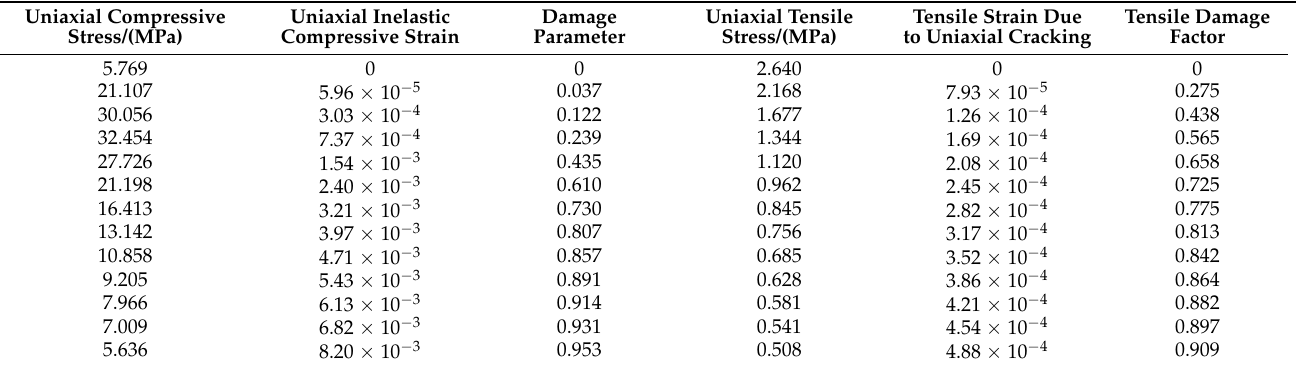
Table 1. Compressive and tensile properties of C50